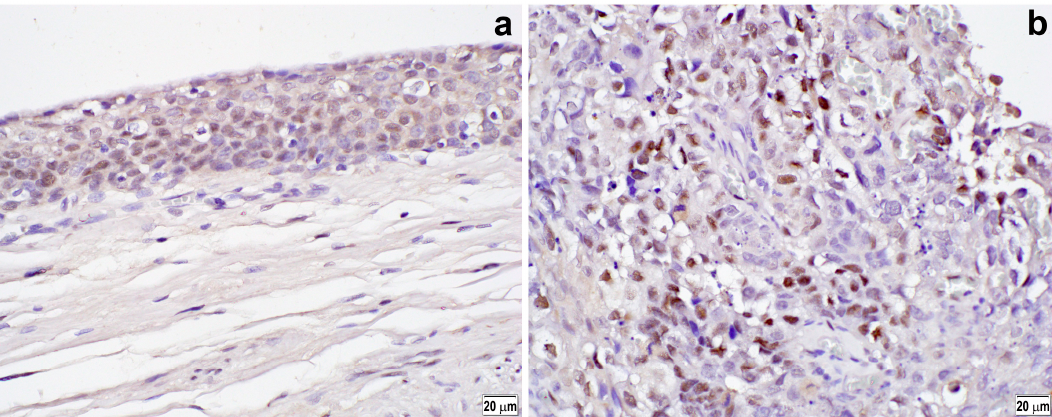
Figure 1. Immunohistochemistry of p-ELK1 in normal urothelial tissue ( a ) and urothelial tumor ( b ). A semi-quantitative analysis of p-ELK1 expression is performed by employing a combination of staining intensity (i.e., weak ( a ), strong ( b )) and distribution (i.e., percentage of immunoreactive cells). Original magnification: 400×.